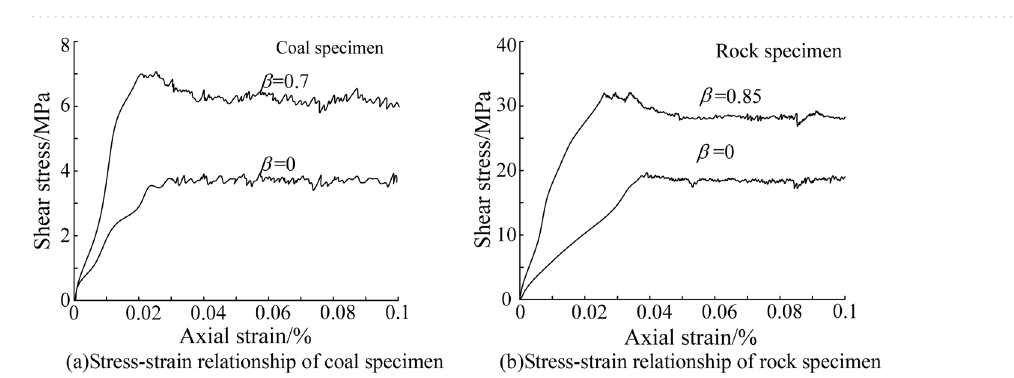
Figure 7. Stress–strain relationship of